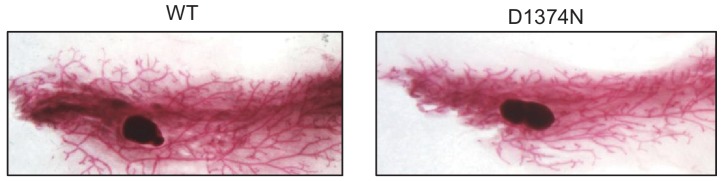
Mammary gland organization in WT and MET D1374N mice.Whole-mount morphology of WT and MET D1374N mammary glands. Pairs #5 of 3-month-old mice were harvested, laid over microscopy slides, and incubated overnight with Carnoy’s fixative. Glands were subsequently stained with Carmine Alum stain, cleared with xylene, and mounted with Permount mounting medium. WT and MET D1374N mammary glands display similar organization, with comparable levels of branching morphogenesis in the whole gland volume.